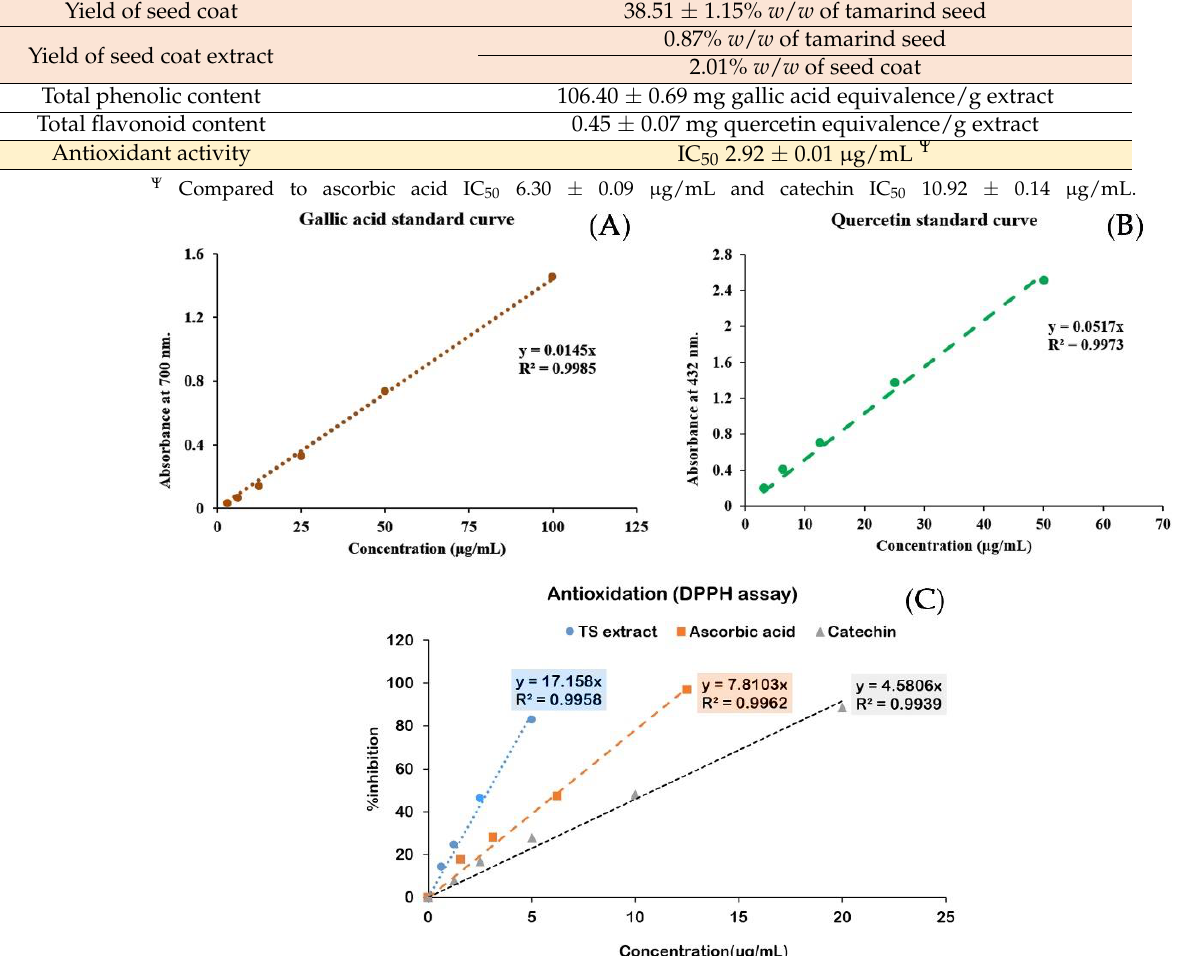
Table 1. Tamarind seed 100 g composed of seed coat 38.51 g yielded 0.77 g of the tamarind seed coat (TS) extract (2.01 % w / w ) which predominantly contained phenolic compound (106.40 ± 0.69 mg/g) rather than flavonoids (0.45 ± 0.07 mg/g), the contents were extrapolating from the standard curves of Gallic acid (Figure A ) and Quercetin (Figure B ), respectively; moreover, the superior antioxidant activity of TS extract (IC 50 2.92 ± 0.01 µg/mL) to the standard antioxidants, ascorbic acid (IC 50 6.30 ± 0.09 µg/mL) and catechin (IC 50 10.92 ± 0.14 µg/mL) was demonstrated, expressed by 50% inhibitory concentration (IC 50 ) derived from the concentration-response curves from DPPH assay (Figure C ).